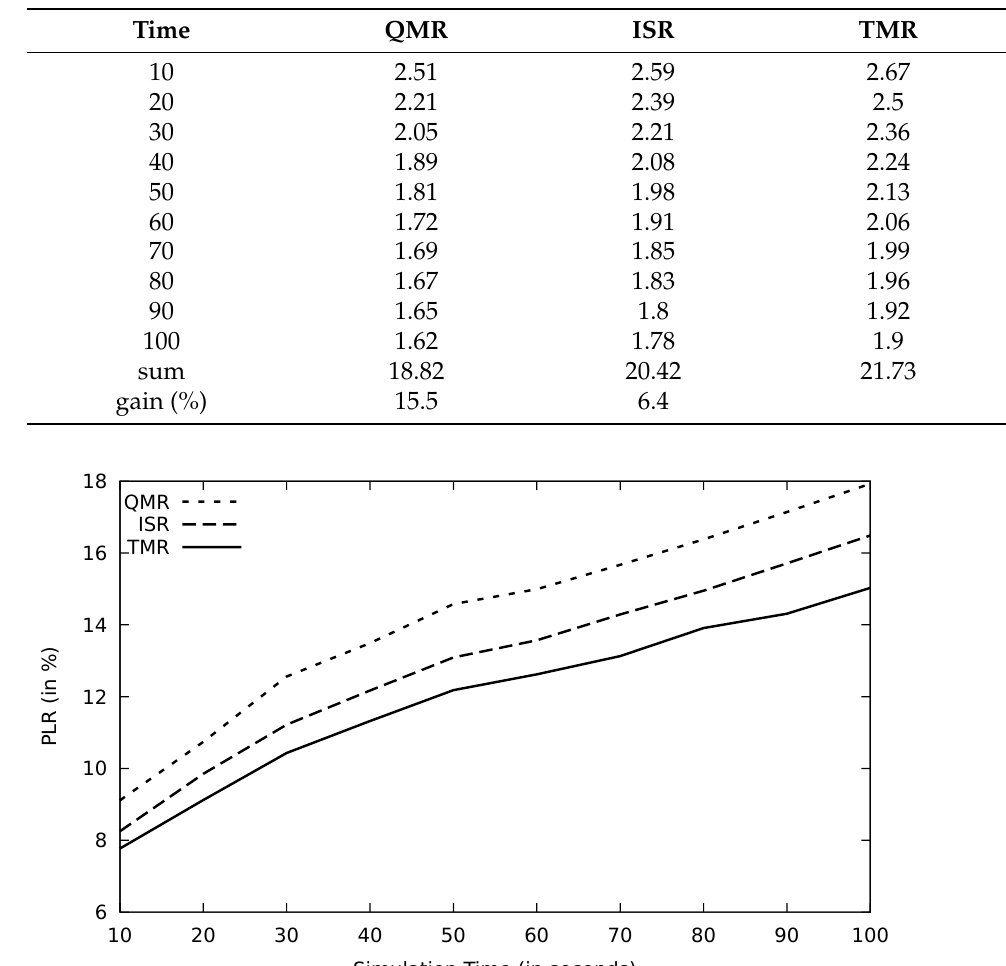
Figure 24. Comparison of EGSR, ISR, and proposed protocol TMR for throughput with simulation time. Table 5. Simulation time vs. throughput of Figure 24.